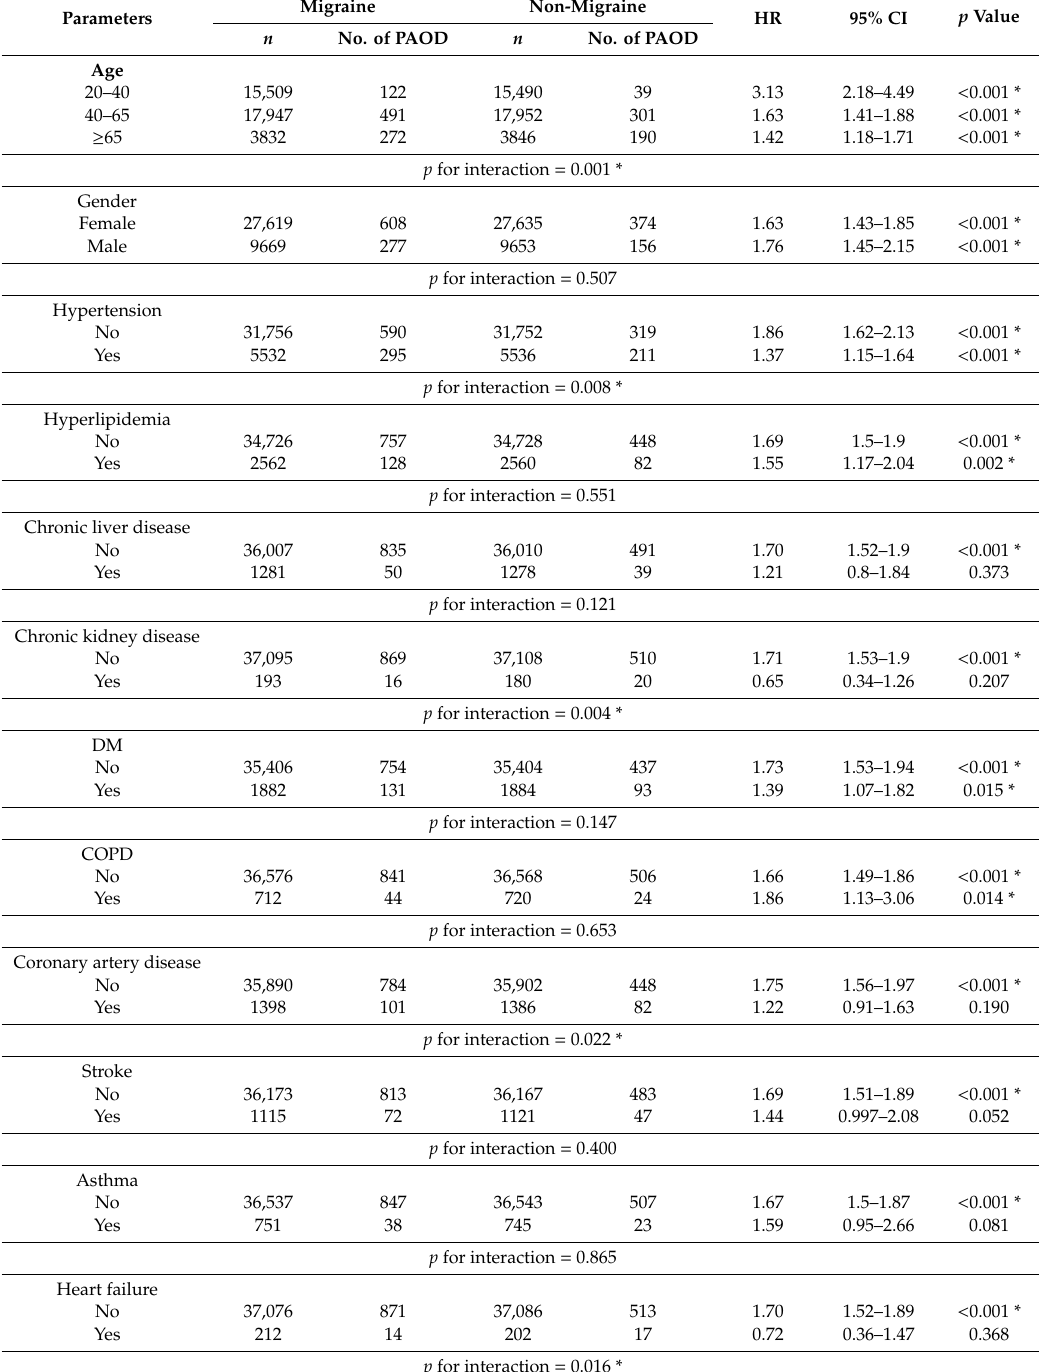
Table 3. Subgroup analysis of risk of peripheral artery occlusive disease between migraine and non-migraine